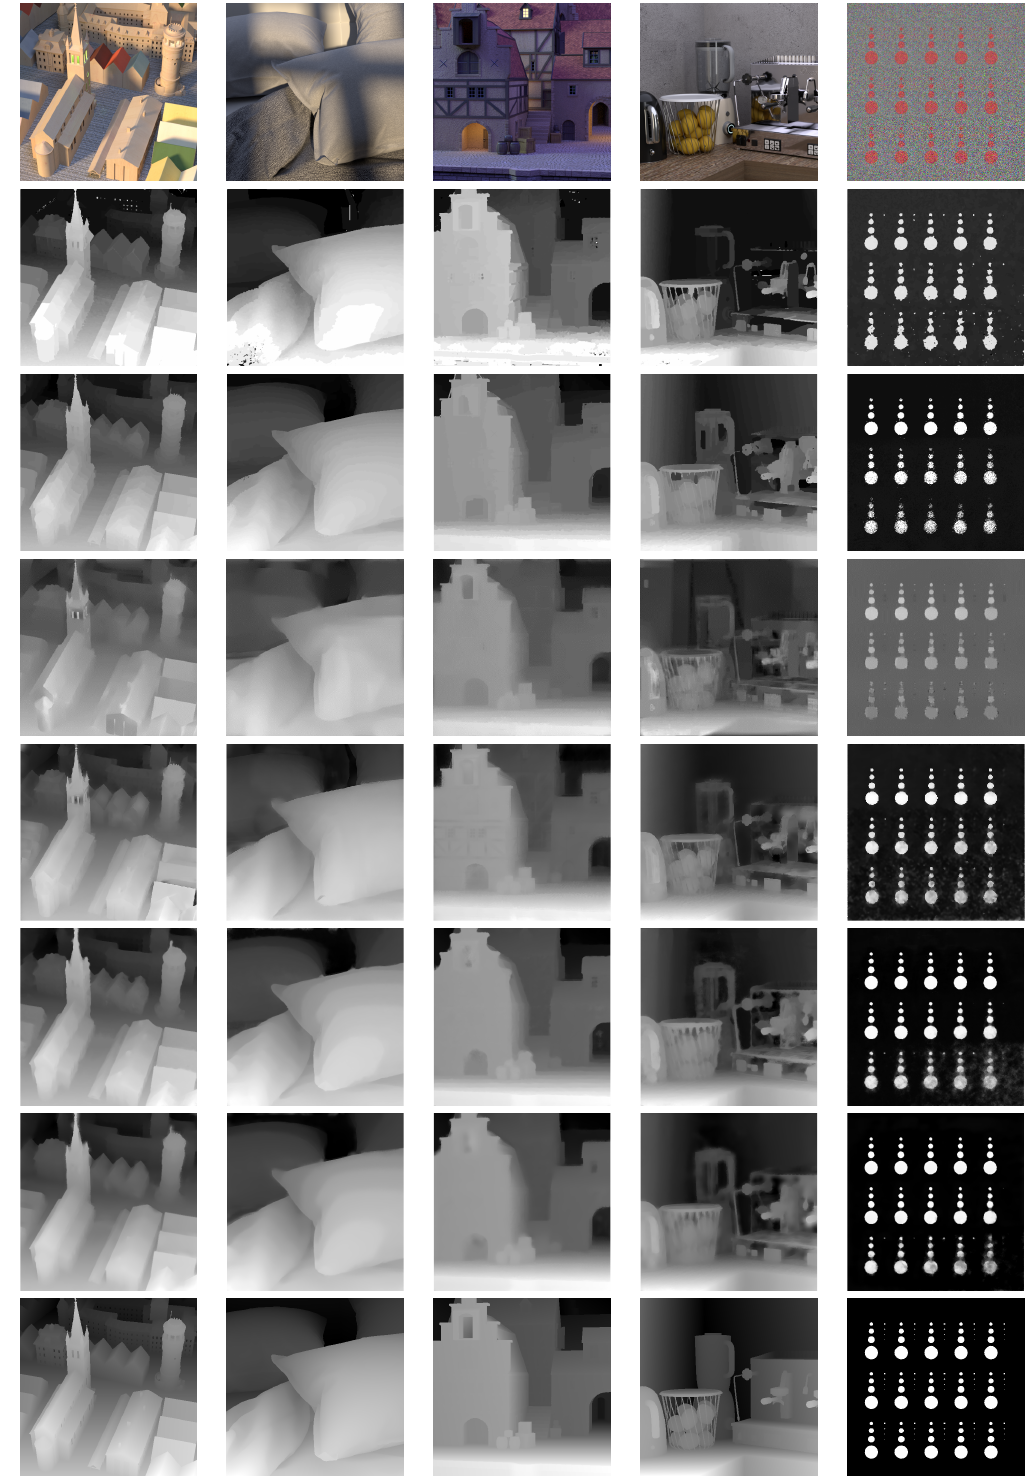
Figure 8. Visual results for the central view of 5 LF images in training configuration of [22], from left to right: town , pillows , medieval2 , kitchen , and dots . (1st row) RGB images [43]. (2nd row) Results for Wang et al. [3]. (3rd row) Results for Williem et al. [32]. (4th row) Results for Feng et al. [22]. (5th row) Results for Schiopu et al. [25]. (6th row) Results for our Stereo method. (7th row) Results for our Proposed method. (8th row) Ground truth disparity